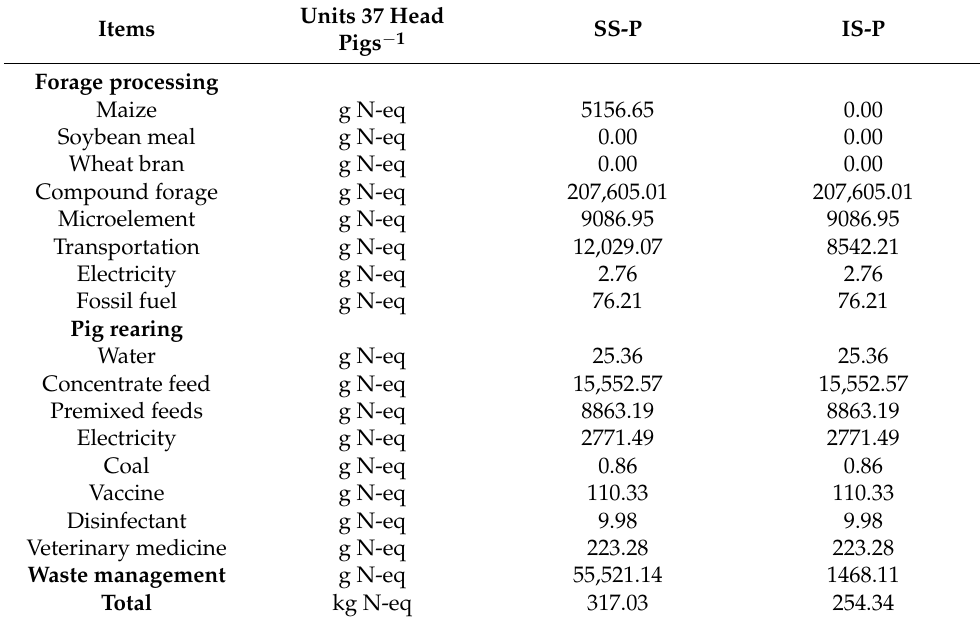
Table 4. NF of pig rearing system. SS-P is the pig rearing of separated system, IS-P is the pig rearing of integrated crop-swine